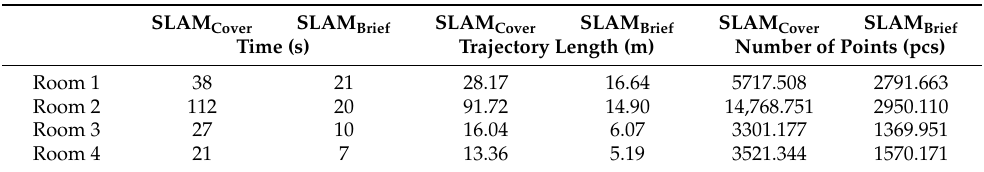
Figure 5. The walking paths of the SLAM measurements:( a ) a path that covers the whole room and ( b ) a path that only visits the room. The path begins being depicted in red and ends as blue. The start- and endpoints are located in the middle of the first floor. ( c ) A close-up of Room 2 with the path that covers the whole room, ( d ) a close up of Room 2 with the path that only visits the room, ( e ) a close up of Room 4 with the path that covers the whole room, and ( f ) a close up of Room 4 with the path that only visits the room. Table 3. The SLAM data characteristics in rooms 1–4.